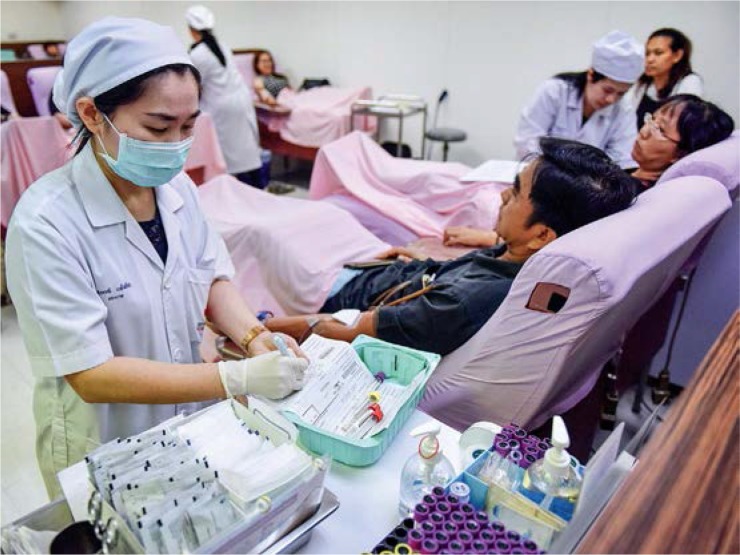
Bangkok, Thailand. A nurse keeps records of a blood donor at the Thai National Blood Centre on 14 June 2017.